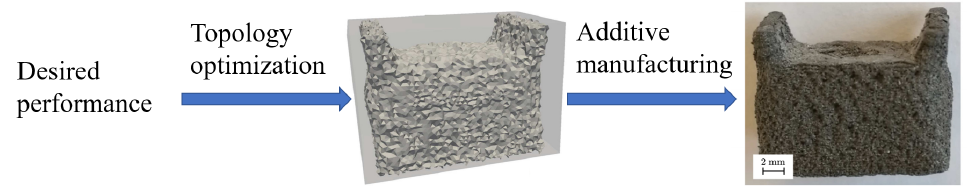
Figure 17. Topology optimized magnet. The design is then additively manufactured via fused deposition modeling. Figure is modified from [71].